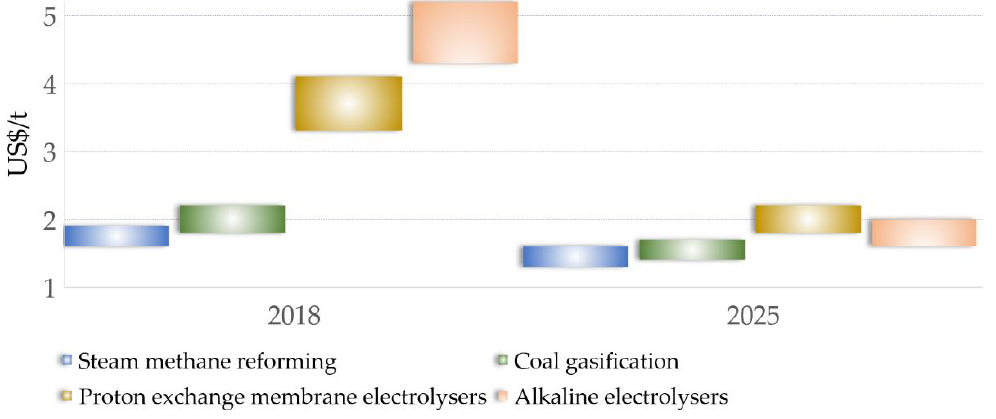
Figure 4. Presented hydrogen production cost (LCOH), USD per kg. Data from [23].